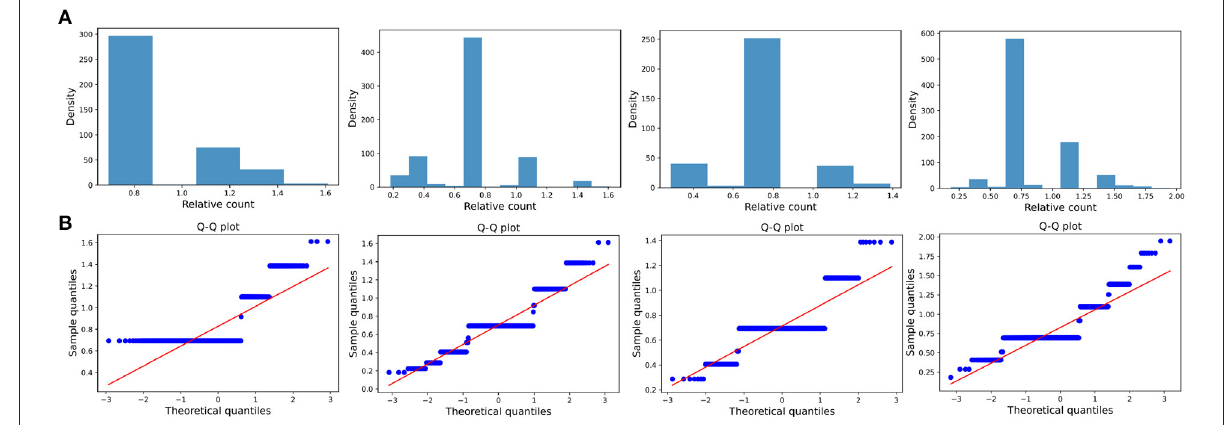
FIGURE6 Transient type. (A) The ratio density of cumulative mentions for the four time intervals. From left to right in the figure, the indicators of the time intervals are: (2000, 2015), (2000, 2020), (2010, 2015), and (2010, 2020), and the x-axis is logarithmically scaled. (B) The Q-Q plots of the distribution of cumulative mentions relative to the normal distribution. If the random variable of the data is a linear transformation of a normal variable, the points will line up on the straight line shown in the plots.